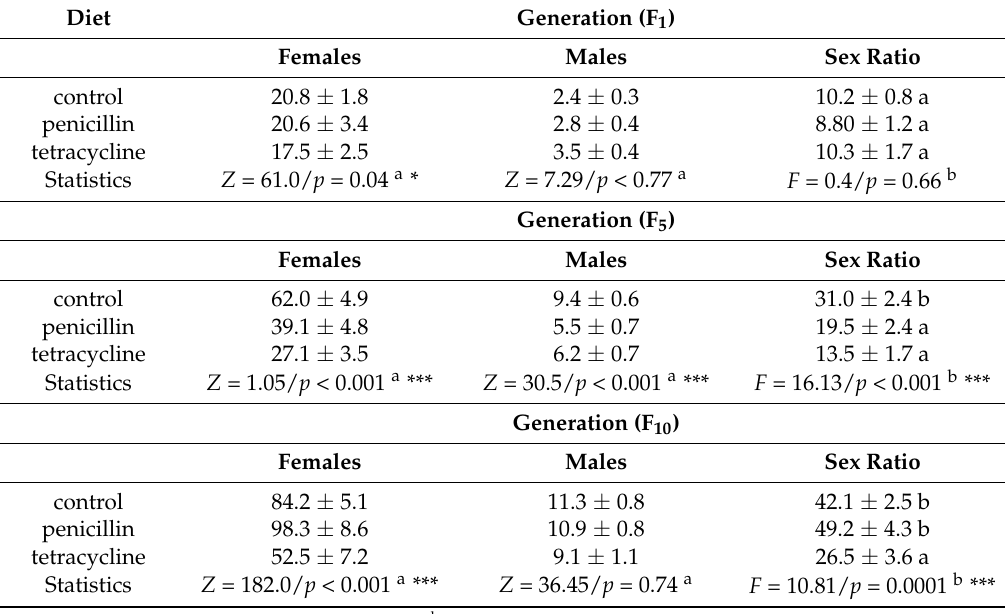
Figure 2. Effects of antibiotics on Hypothenemus hampei population growth and fecundity. ( a ) Total number of individuals (including eggs, larvae, pupae, juveniles, and adults) for F 1 , F 3 , F 5 , and F 10 generations ( b ) Fecundity (number of eggs per female). Means ± SE are shown. Table 1. Number of females, males, and sex ratio of Hypothenemus hampei reared in artificial diets with and without antibiotics; Means ± SE and F: M ratio per vial for F 1 , F 5 , and F 10 generations.